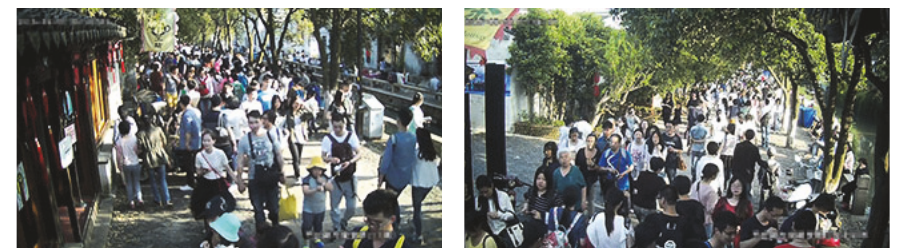
Figure 11: The images of scene 2 and scene